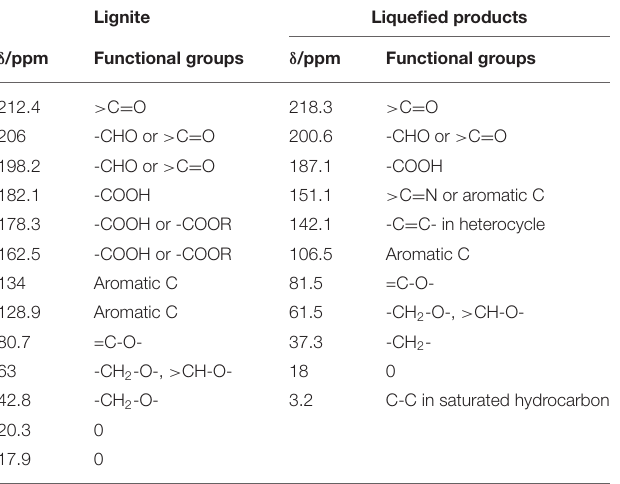
TABLE 3 | Structure parameters of Zhaotong lignite and liquefied product according to 13 C NMR. Parameter Zhaotong